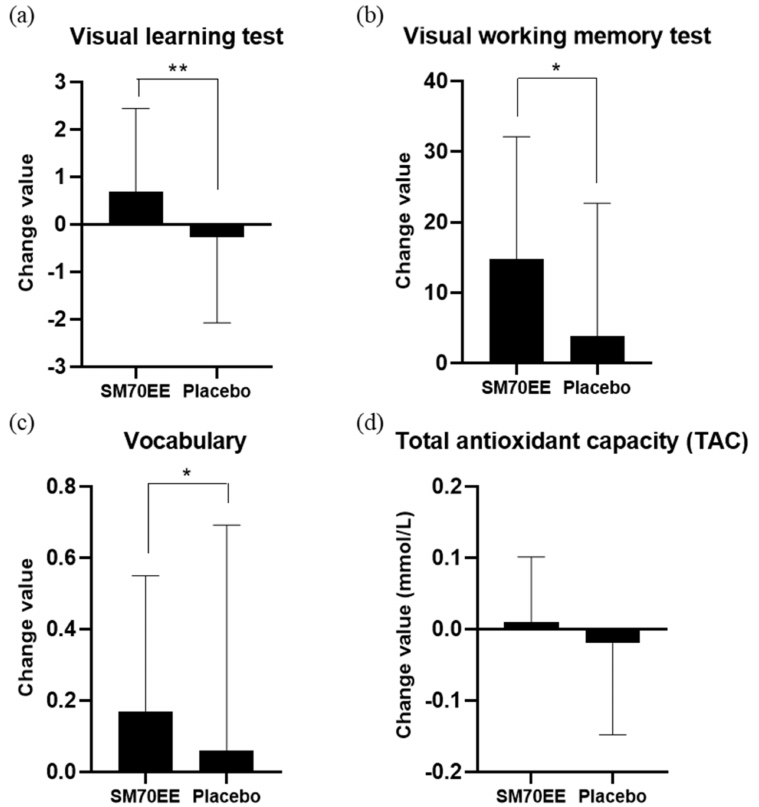
Figure 2. Changes of values in ( a ) visual learning test, ( b ) visual working memory test, ( c ) vocabulary (MoCA-K) and ( d ) total antioxidant capacity (TAC) of the participants. There was a significant difference in the changes for the visual learning test, visual working memory test, and vocabulary (MoCA-K) between the SM70EE and placebo groups after 12 weeks. * p < 0.05, ** p < 0.01. Abbre- viations: SM70EE, Spirulina maxima 70% ethanol extract; MoCA-K, Korean version of the Montreal Cognitive Assessment.